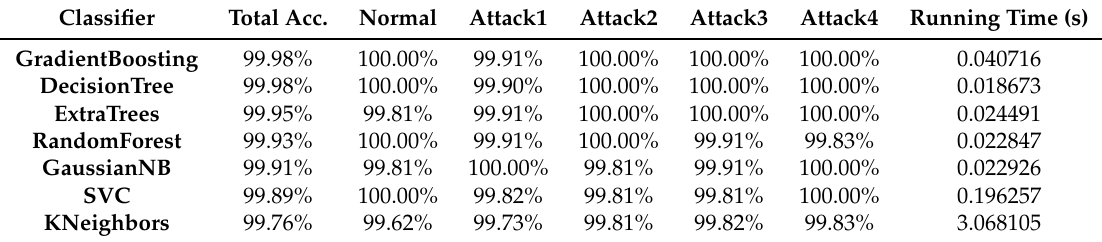
Table 2. Classification accuracy and running time of all evaluation programs with different machine learning (ML)